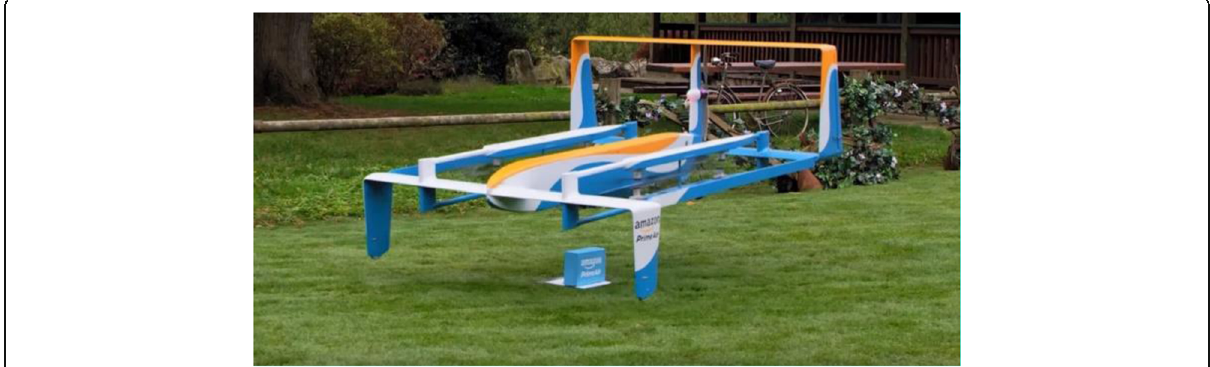
Fig. 3 Amazon Prime Air drone delivery prototype